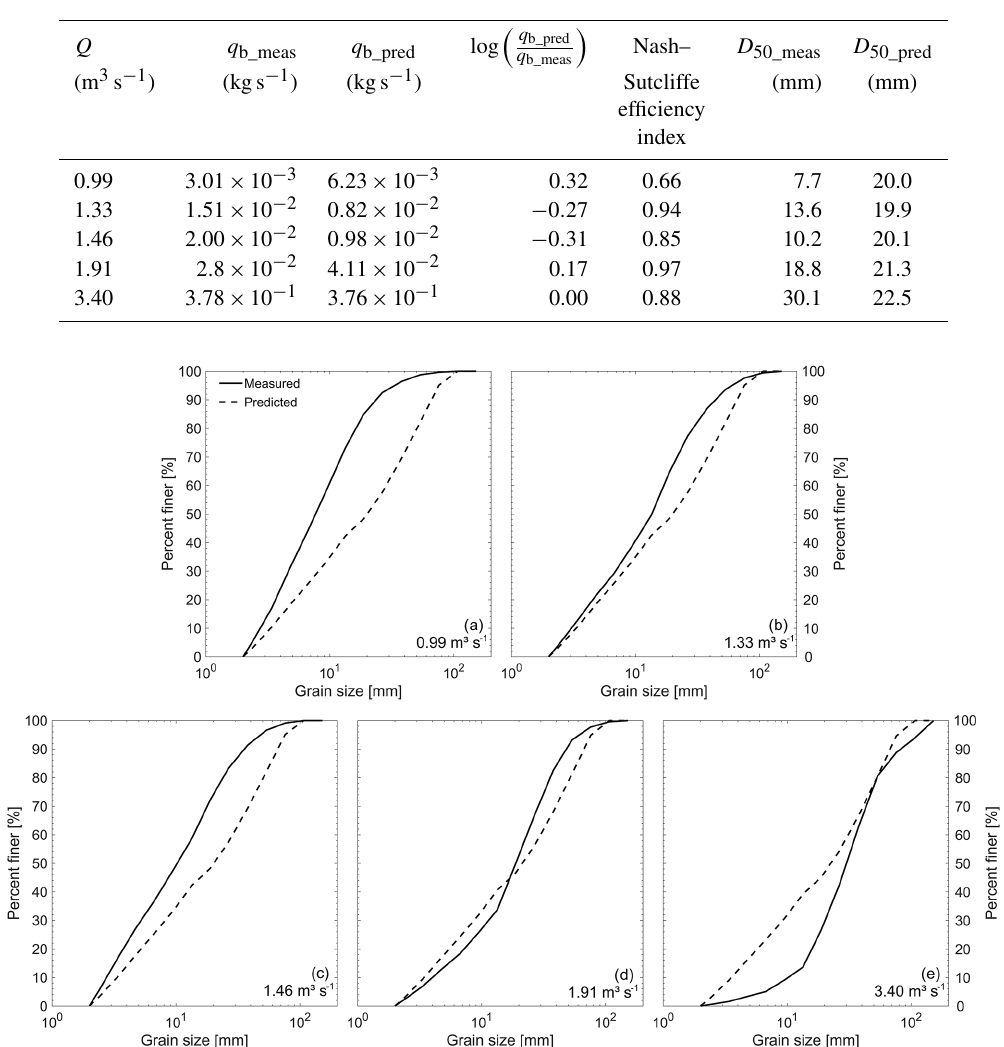
Table 2. Modeled ( q b_pred ) and observed ( q b_meas ) bed load transport rates and modeled ( D 50_pred ), Nash–Sutcliffe efficiency index, and observed ( D 50_meas ) median grain size for the events used in the calibration of Eq. (8).